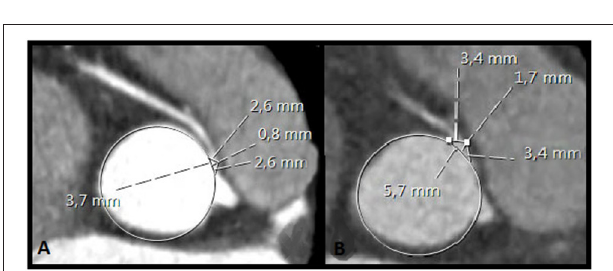
FIGURE 4 | Coronary triangulated orifice area (CTOA) pre- and postoperatively in the same patient ( A,B , respectively). The ostial diameter increased from 3.7 to 5.7mm. The CTOA increased from 1.5 to 4.9 mm ²